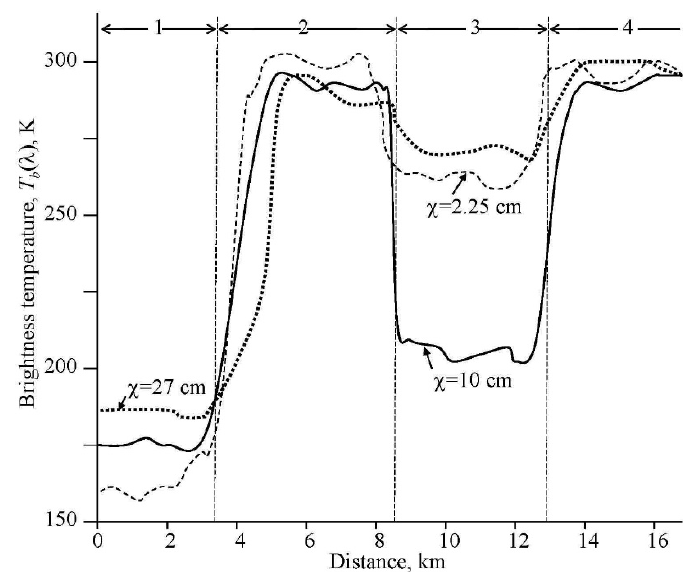
Figure 5. Typical brightness temperature distributions along the IL-18 trace above the pixels near the Yenisey River recorded by different microwave radiometers. Brightness temperatures were recorded on August 14, 1989, 5 days after the rainfall. The numbers above the curves indicate the land cover: 1—Yenisey River zone, 2—taiga, 3—peat bog and 4—taiga.